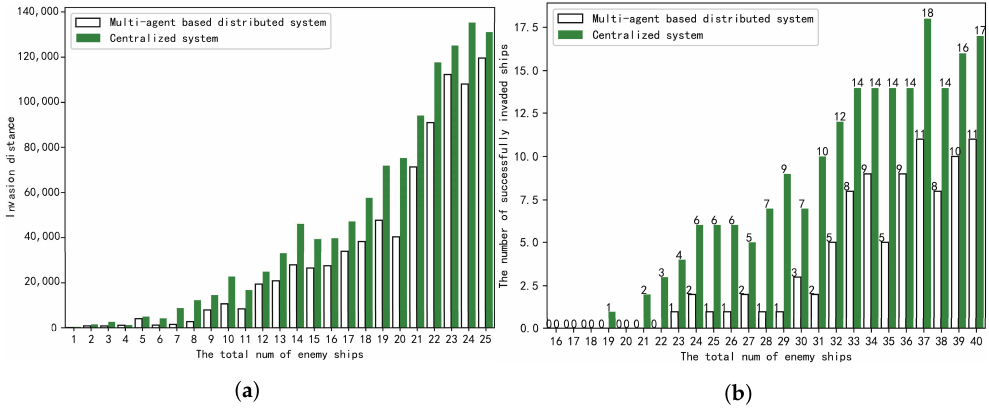
Figure 7. Experimental results on the invasion performances of the enemy ships. ( a ) The total invasion distance of all enemy ships. ( b ) The total number of successfully invaded ships.